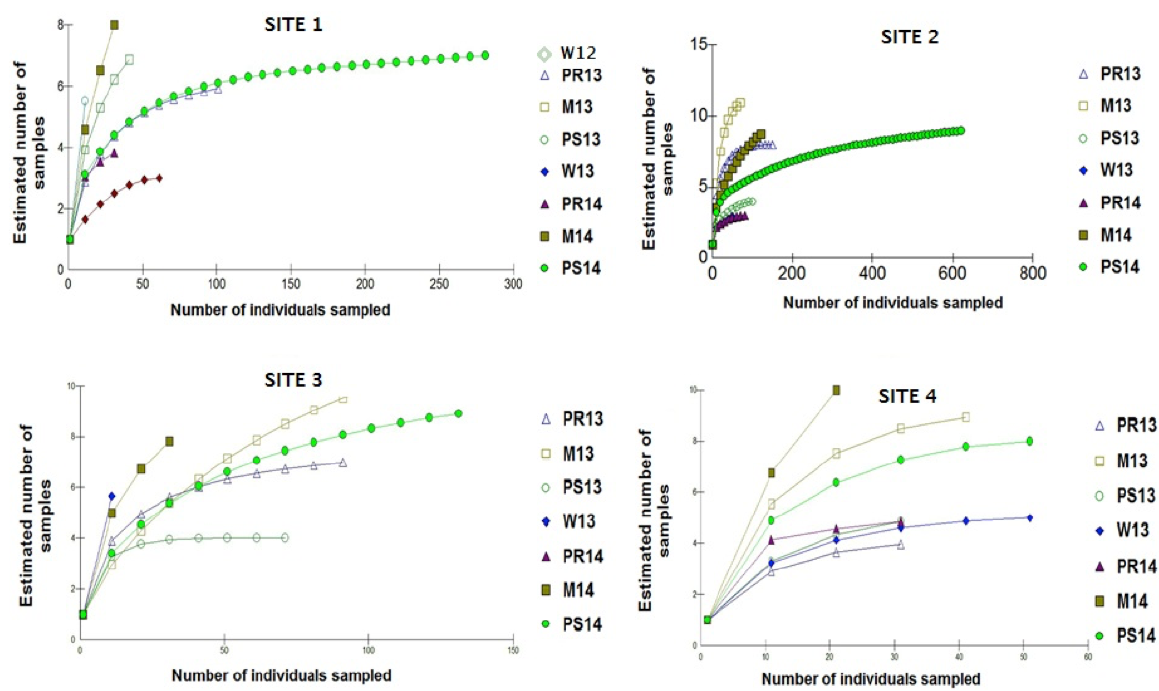
Figure 7. Sample based rarefaction curves in relation to sample size of four study sites during different seasons. (W12 = winter2012; PR13 = Premonsoon2013; M13 = Monsoon2013; PS13 = Postmonsoon2013; W13 = Winter2013; PR14 = Premonsoon2014; M14 = Monsoon2014; PR14 = Postmonsoon 2014)